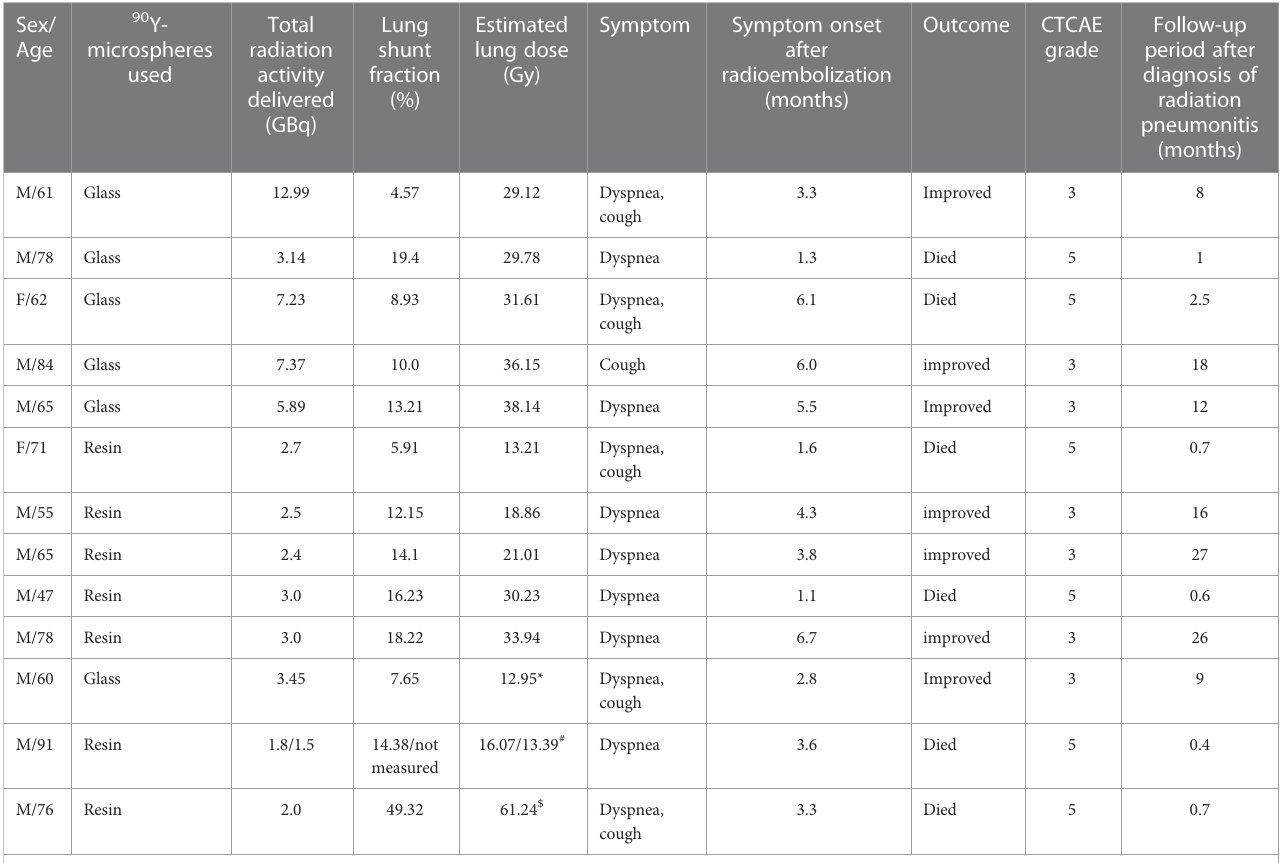
TABLE 2 Treatment factors, symptom and outcome of radiation